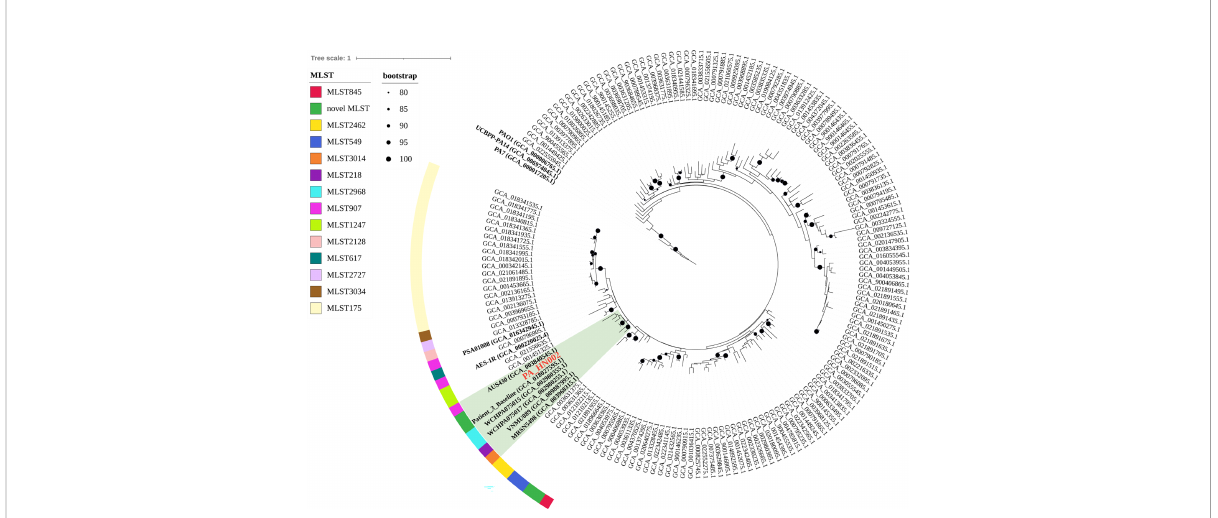
FIGURE 4 Phylogenetic position of PA_HN002. The phylogenetic tree was constructed based on 6,800 P. aeruginosa genomes from GenBank using PhyloPhlAn version 3.0 and the most related 168 genomes to PA_HN002 were presented. Three widely used reference genomes of PAO1, PA7 and PA14 were included and shown. Genomes located within the same clade as PA_HN002 were shaded in green. MLST types were shown in different colors for the genomes that were close to PA_HN002. Black dots on the nodes were bootstrap values and those greater than 80 were